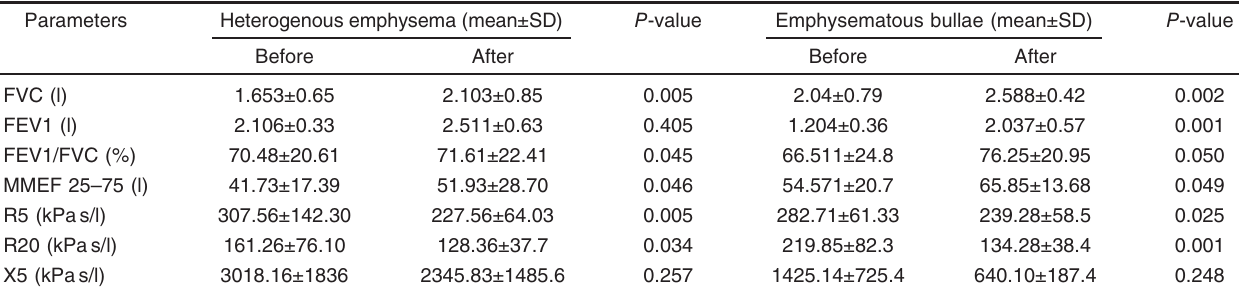
Table 2 Spirometry and impulse oscillometry parameters before and after bronchoscopic lung volume reduction in both groups Parameters